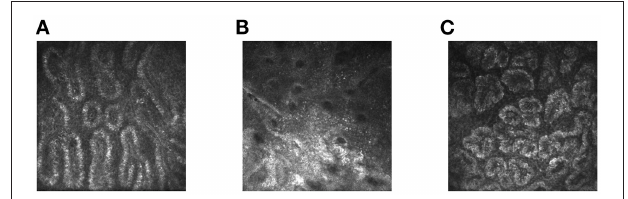
FIGURE 1 | In-vivo laser confocal microscope images of obstructive (A) and atrophic MGD (B) and healthy eyes (C) . MGD, meibomian gland